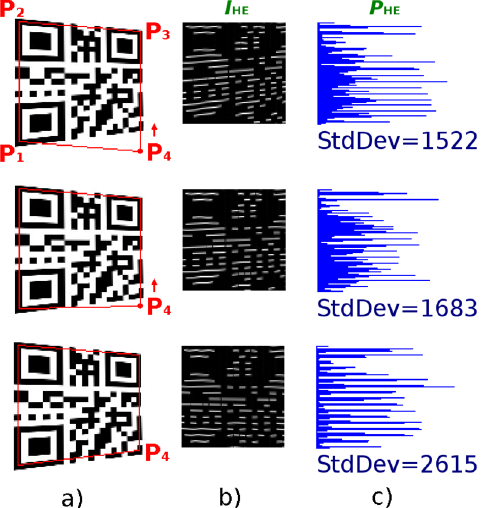
Figure 12. Identification of perspective deformation of QR Code: ( a ) QR Code; ( b ) horizontal edges; ( c ) horizontal projection of horizontal edges.